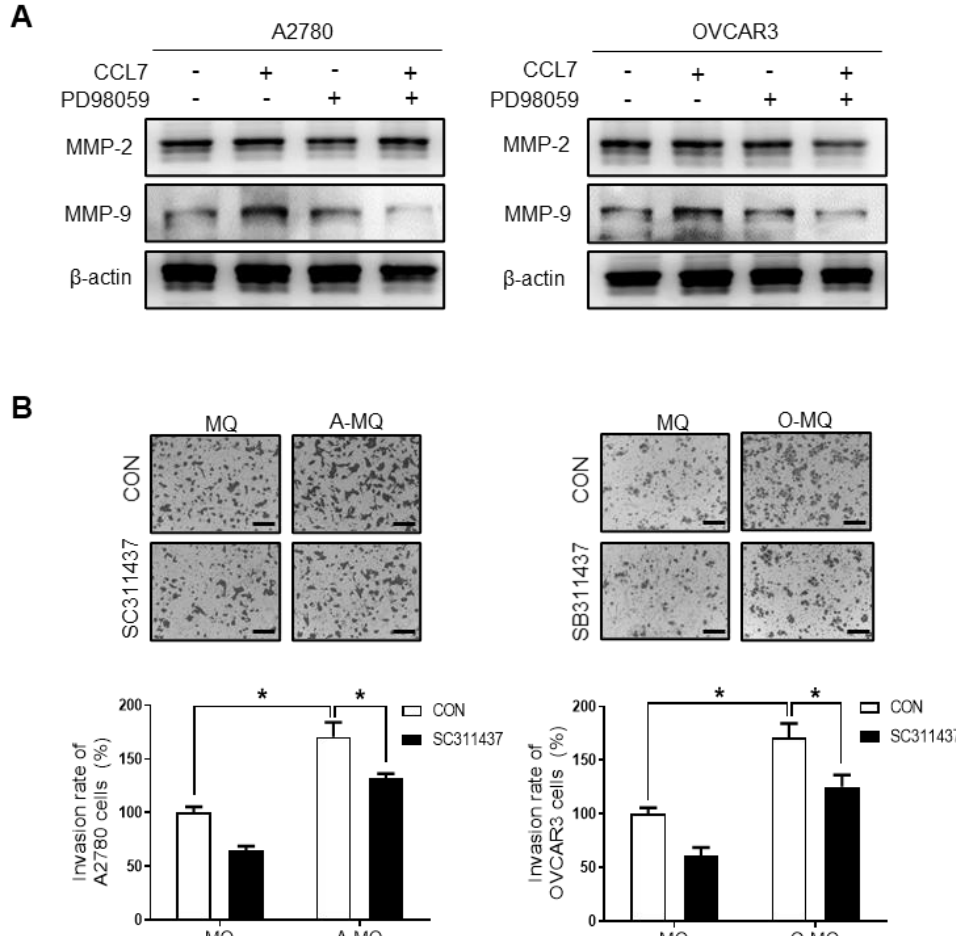
Figure 7. Involvement of matrix metalloproteinase (MMP)-9 in CC chemokine ligand 7 (CCL7)-induced ovarian cancer cell invasion. ( A ) A2780 and OVCAR3 cells were pretreated with the MAPK/ERK Kinase (MEK) inhibitor, PD98059 (70 µ M), for 1 h, then with recombinant CCL7 (100 ng/mL) for 24 h. The expression of MMP-2 and MMP-9 in A2780 and OVCAR3 cells was detected by Western blot assays. ( B ) A2780 and OVCAR3 cells were pretreated with the MMP-9 inhibitor, SC311437 (20 µ M), for 1 h, then with the conditioned medium of macrophages (MQ), macrophages stimulated by A2780 cells (A-MQ), and macrophages stimulated by OVCAR3 cells (O-MQ) for 24 h. The cancer cells were seeded in Matrigel-coated upper chambers and allowed to migrate for 48 h. Scale bar, 100 µ m. The results represent the means ± SD of at least three independent experiments. Original Western Blots shown in Figure S6. * p < 0.05.